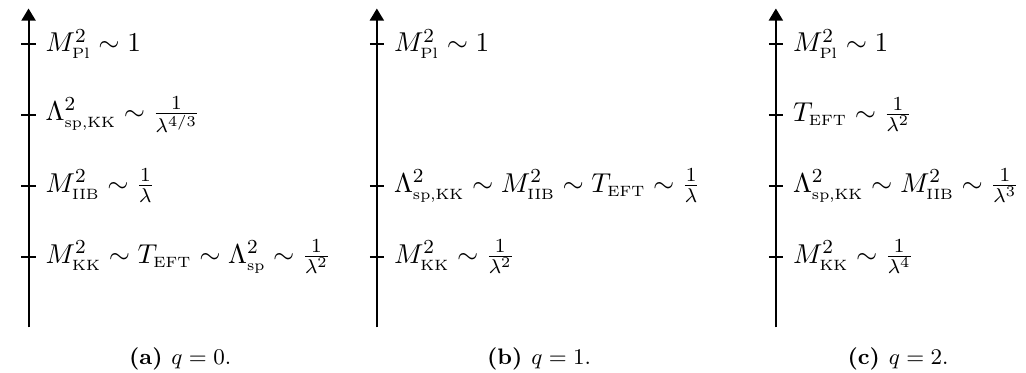
Figure 1. Characteristic scales for the three possible types of quasi-primitive EFT string limits in the Kähler moduli space of F-theory compactified to four dimensions. The limits are parametrized by λ → ∞ . The topological invariant q classifies the possible quasi-primitive EFT string limits, as explained in section 2.2. The limit with q = 0 is an emergent string limit, which stays effectively four-dimensional. Limits with q = 1 describe effective decompactifications to six dimensions, while limits with q = 2 decompactify to ten dimensions and the 7-brane gauge sector is a defect theory. This picture summarizes the findings of section